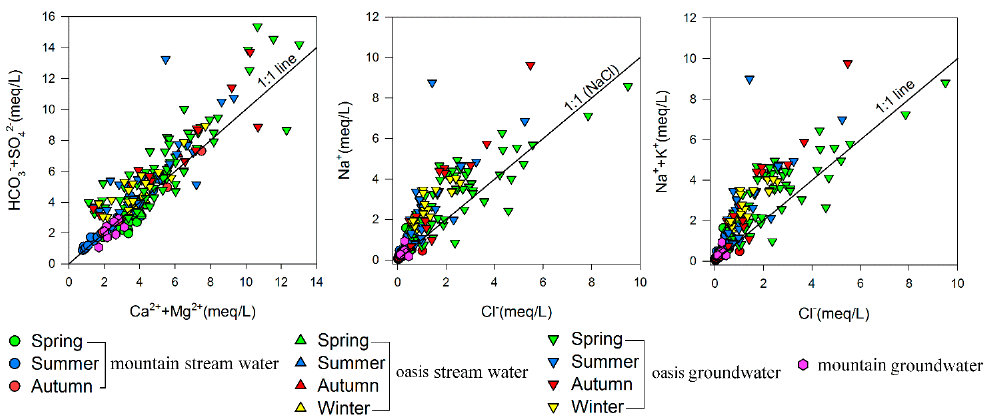
Figure 6. Scatter diagrams showing relationship between ( a ) Ca 2 + + Mg 2 + vs. HCO 3 − + SO 42 − ; ( b ) HCO 3 − vs. Ca 2 + ; ( c ) HCO 3 − vs. Mg 2 + ; ( d ) SO 42 − vs. Ca 2 + ; ( e ) SO 42 − vs. Mg 2 + ; ( f ) SO 42 − vs. Na + ; ( g ) Cl − vs. Ca 2 + ; ( h ) Cl − vs. Mg 2 + ; and ( i ) Cl − vs. (Na + + K + ) of stream water and groundwater in different seasons.